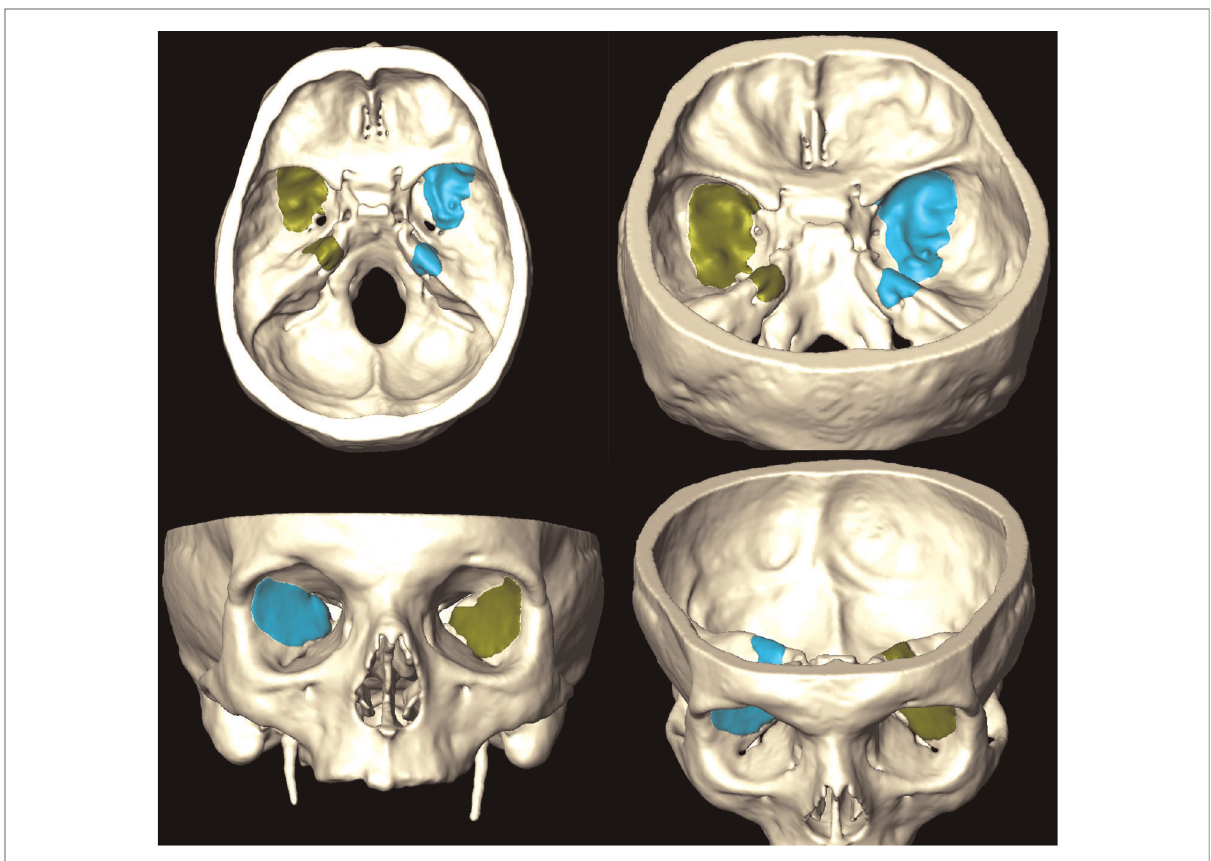
FIGURE 7 Amira software 3D reconstructions from postdissection CT scans, highlighting the amount of bone removal at the level of the middle cranial fossa and petrous